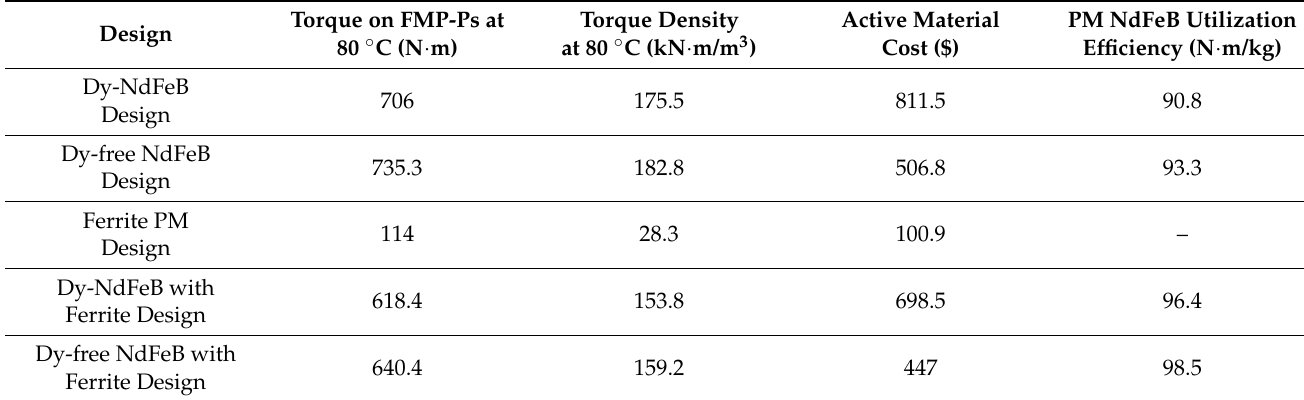
Table 7. Torque capabilities and cost analysis.